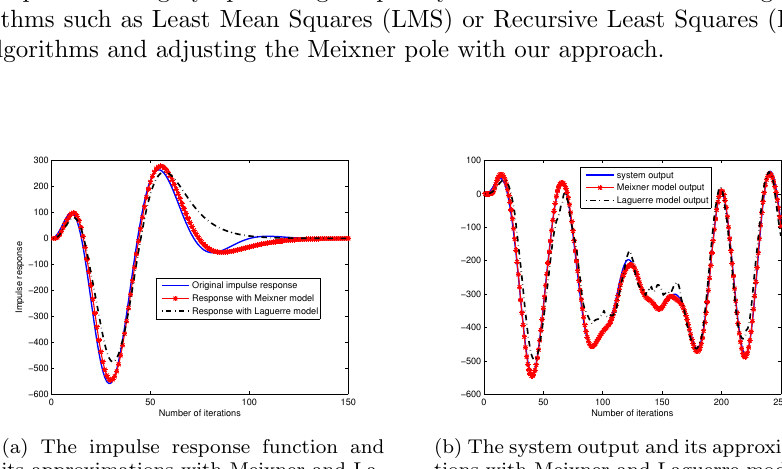
Figure 5. Validation of the Meixner and Laguerre